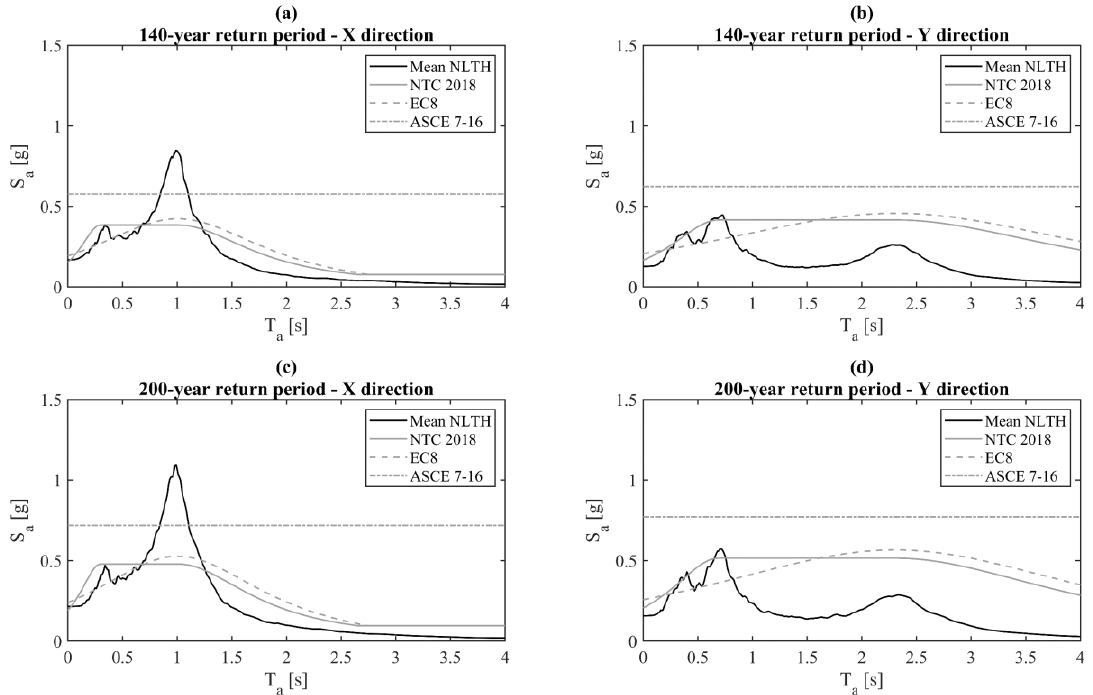
Figure 11. Comparison between absolute acceleration top floor response spectra obtained from nonlinear time–history analyses and code formulations: ( a ) RP = 140 years, X direction; ( b ) RP = 140 years, Y direction; ( c ) RP = 200 years, X direction; ( d ) RP = 200 years, Y direction.